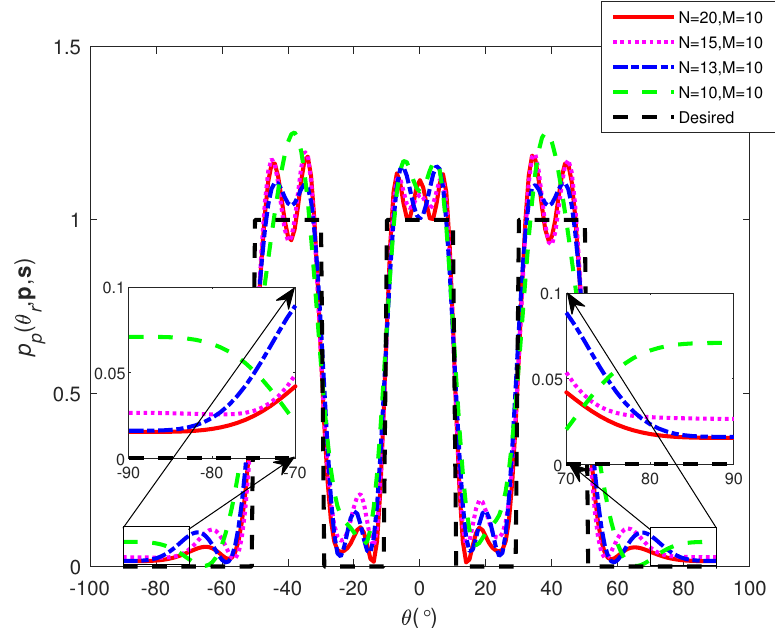
Figure 5. The beampattern matching performance comparison with M = 10 antennas and a different number of grid points.